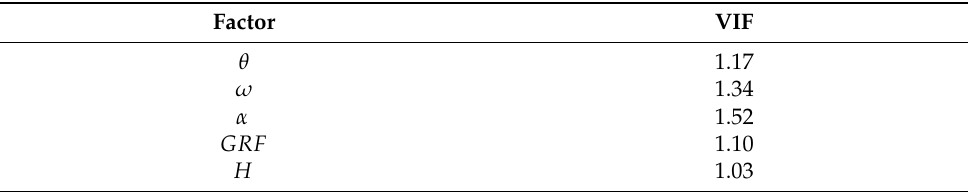
Table 4. Multicollinearity test for all factors.